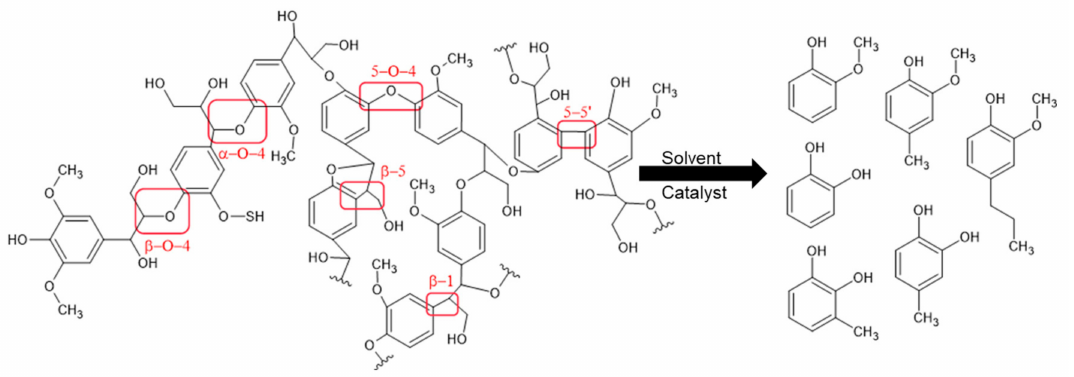
Figure 5. Depolymerization of lignin by